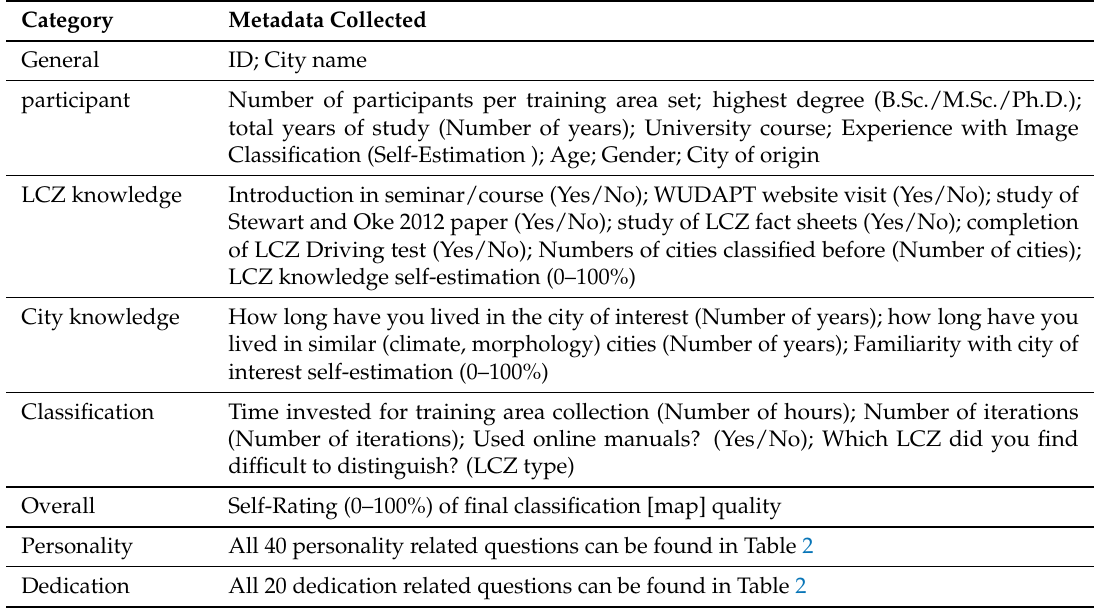
Table 1. Metadata collected from the participants. The allowed answers are provided in brackets (After Bechtel et al.